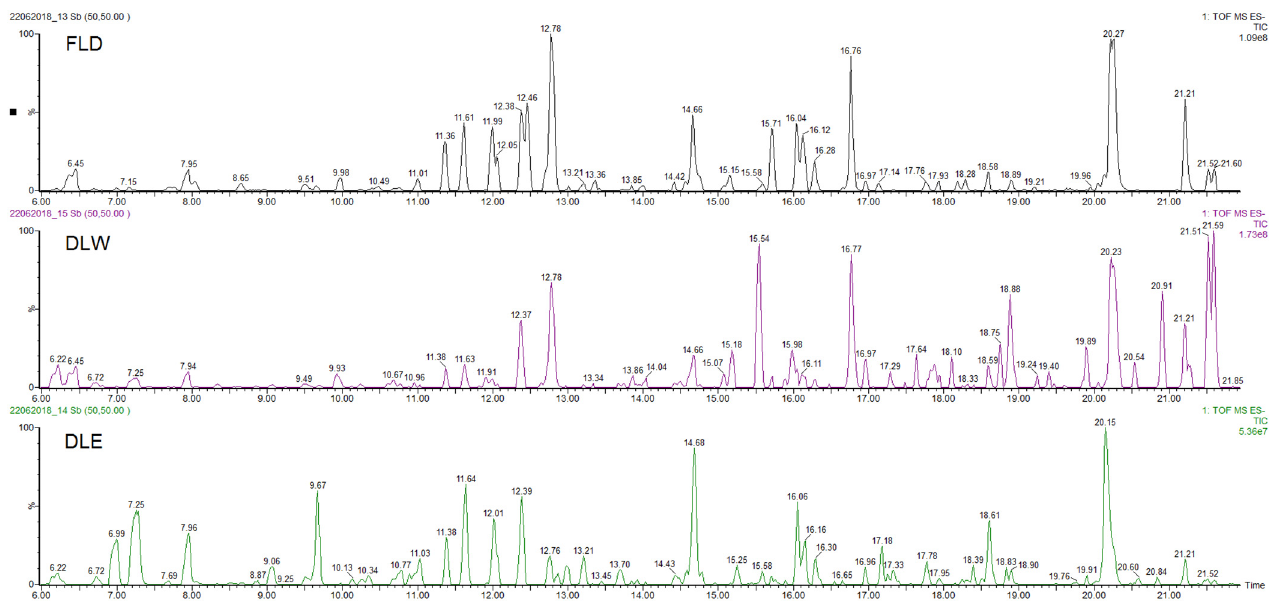
Figure 2. UPLC-DAD-MS/MS Total Ion Chromatogram (TIC) profiles of Plectranthus neochilus Schltr. extracts.